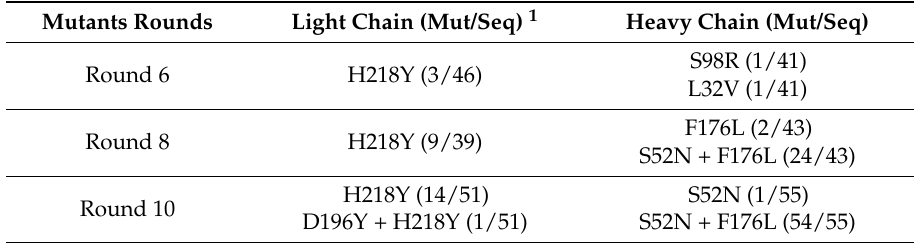
Figure 3. Flow cytometry cell sorting results during affinity maturation. Each round of maturation, the 3B1 antibody on the cells were stained with anti-human-IgG-APC (1:20 dilution) and HMGB1-GFP (0.5 µg/mL). Cells with better HMGB1-GFP binding (0.05–0.1% of the cells) were sorted out and expanded for another round of sorting. Anti-human-IgG-APC: Allophycocyanin conjugated Mouse Anti-Human IgG antibody. HMGB1-GFP: High mobility group box 1 and GFP fusion protein. Table 1. Antibody mutants.